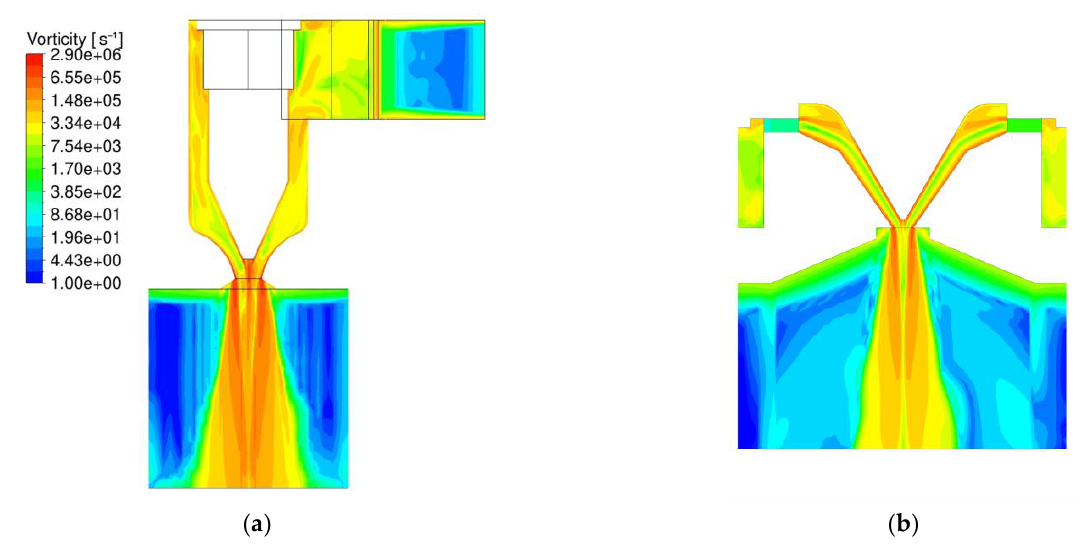
Figure 10. Comparison of the vorticity: ( a ) Nanoval process; ( b ) meltblown process. As soon as the air streams exit the nozzle, a strong interaction between the streams occurs since they all draw secondary air from the same reservoir. Therefore, the streams can no longer be seen as independent but must be simulated within one setup. For this simulation, the periodicity is exploited, and only three columns of nozzles are computed